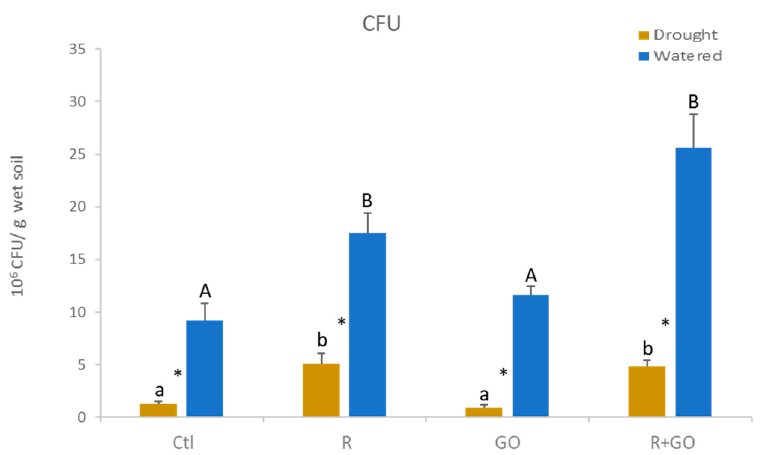
Figure 1 . Colony forming units (CFU) in watered (blue bars) and drought (brown bars) sand where maize plants grew for 28 days at different conditions. Ctl—no addition of graphene oxide nanosheets, no bacterial inoculation; R—no addition of graphene oxide nanosheets, inoculation with Rhizobium strain E20-8; GO—addition of graphene oxide nanosheets, no bacterial inoculation; R + GO—addition of graphene oxide nanosheets and inoculation with Rhizobium strain E20-8. Values are means of three replicates + standard error. Different uppercase letters indicate significant differences ( p < 0.05) among conditions in watered sand, different lowercase letters indicate significant differences among conditions under drought, and asterisks indicate significant differences between watered and drought for the same condition.